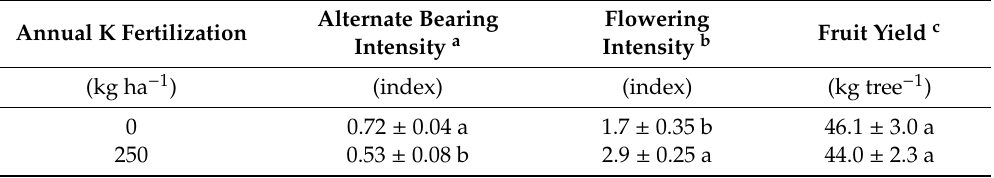
Table 4. Influence of K fertilization on alternate bearing .